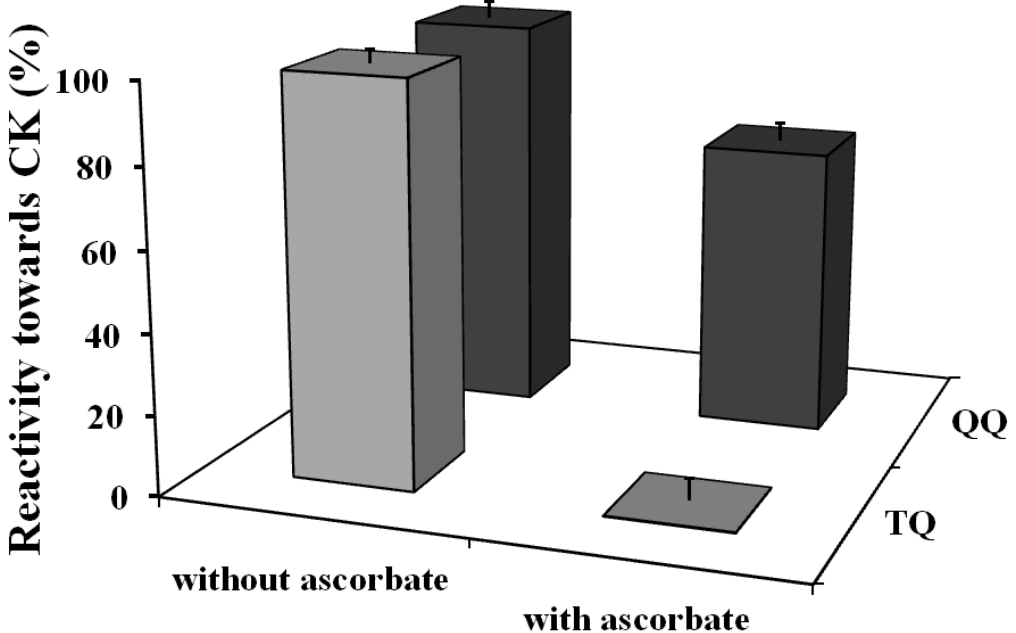
Figure 2. Effect of quercetin and tamarixetin oxidation on the enzyme activity of CK in presence of ascorbate. Quercetin and tamarixetin (50 µM) were oxidized by 50 µM H and HRP, at equal rate of oxidation (5 µM/min) in presence of 6.2 µM CK. The enzyme activity of CK was measured in the absence or presence of 50 µM ascorbate and expressed as percentage of the CK inhibition obtained without ascorbic acid. Data are shown as mean ± SE ( n =